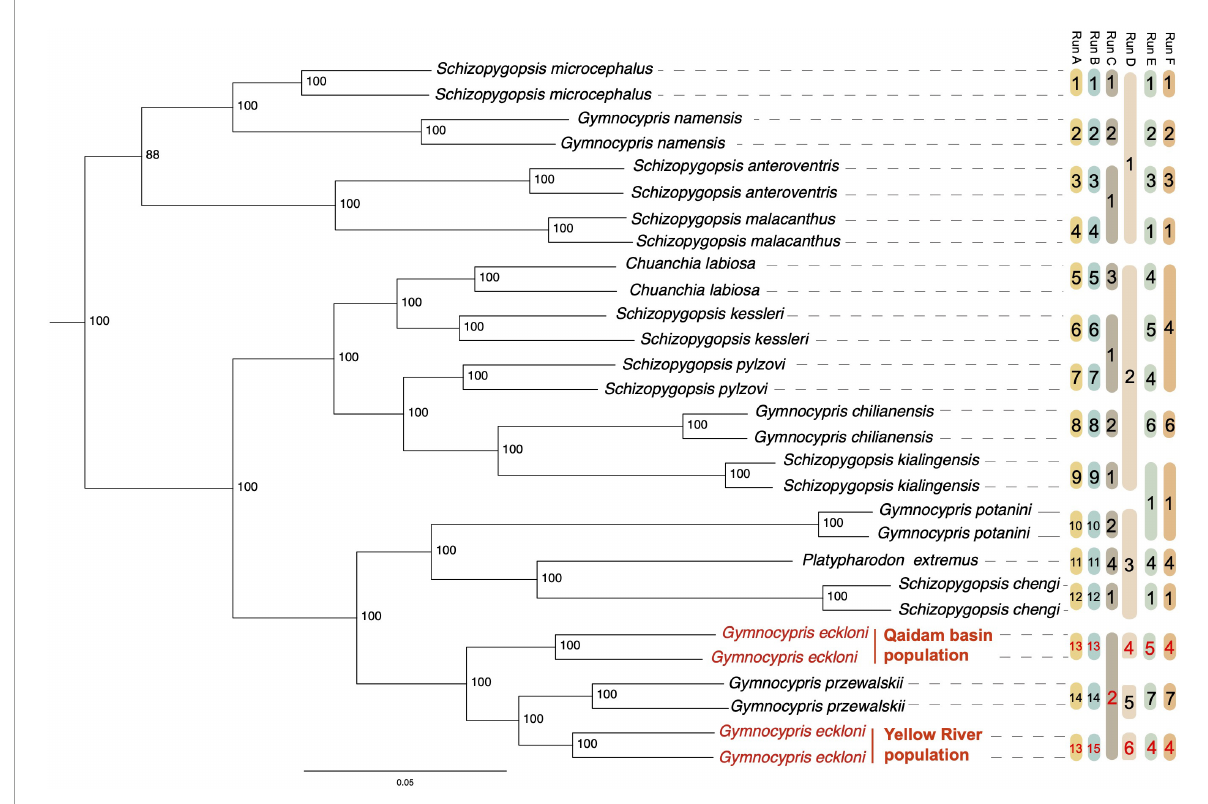
FIGURE2 ML tree constructed by SALF-seq, plus a bar named Run D of GMYC results. Bootstrap support values were labeled in each node, and YR and QB populations of Gymnocypris eckloni were highlighted in red. Outgroup Oxygymnocypris stewartii was excluded from this tree. Remarks: The bars from Run A to Run F are the alternative species model for SNAPPER analyses. The same code in a bar refers to the same group for an alternative model. (1) Run A, lumping by the current taxonomy delimited based on morphological discrimination. (2) Run B, lumping by morphological discrimination but splitting the two populations of G. eckloni . (3) Run C, lumping by genus. (4) Run D, lumping by GMYC. (5) Run E, lumping by basin/habitat. (6) Run F, lumping by basin/habitat but merging the two populations of G. eckloni